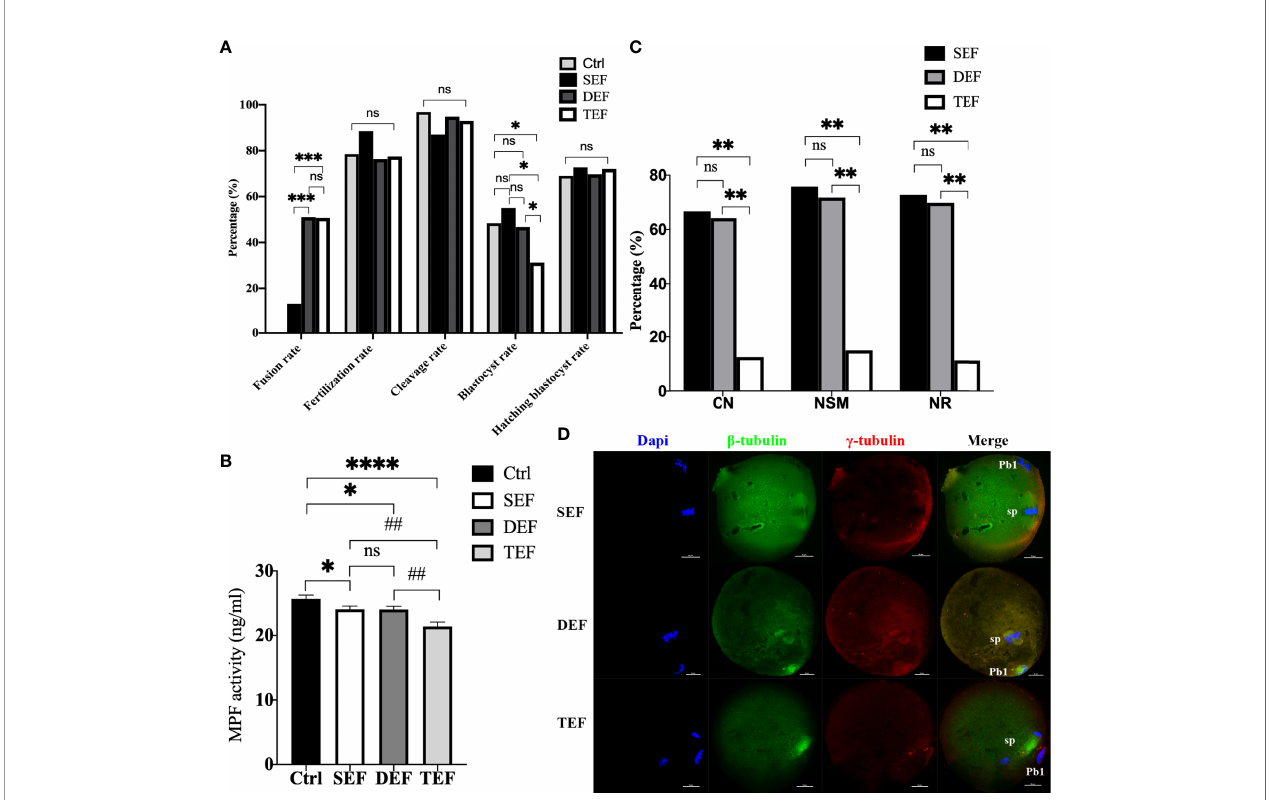
FIGURE 2 | The electrofusion stimulation number in the ST process should be minimized, with no more than 2 times being appropriate. (A) Culture results. The fusion rate in DEF and TEF was signi fi cantly higher than that in SEF. The blastocyst rate in TEF decreased signi fi cantly, with no signi fi cant difference between Ctrl, SEF and DEF. SEF, DEF, and TEF are the single electrofusion group, the double electrofusion group, and the triple electrofusion group, respectively. The data is expressed as a percentage (%). *P<0.05, ***P<0.001, and ns P>0.05. (B) Single or double electrofusion had little effect on the MPF activity, while triple electrofusion resulted in a very signi fi cant decrease. The data is expressed as mean ± standard deviation. *P<0.05, ****P<0.0001. ## P<0.01, ns, P>0.05. Value, the MPF activity per 100 oocytes (ng/ml). (C) Immuno fl uorescence staining results indicated that CN, NSM, and NR in TEF were signi fi cantly lower than that in SEF and DEF, with no statistical difference between SEF and DEF. The data is expressed as a percentage (%). **P<0.01, ns P>0.05. (D) Representative images in SEF and DEF were both normal in terms of chromosomes, spindle morphology, and g -tubulin location. In the TEF group, the chromosomes were separated in advance, the spindle morphology was abnormal, and g -tubulin localization was disordered. Scale bar, 20 m